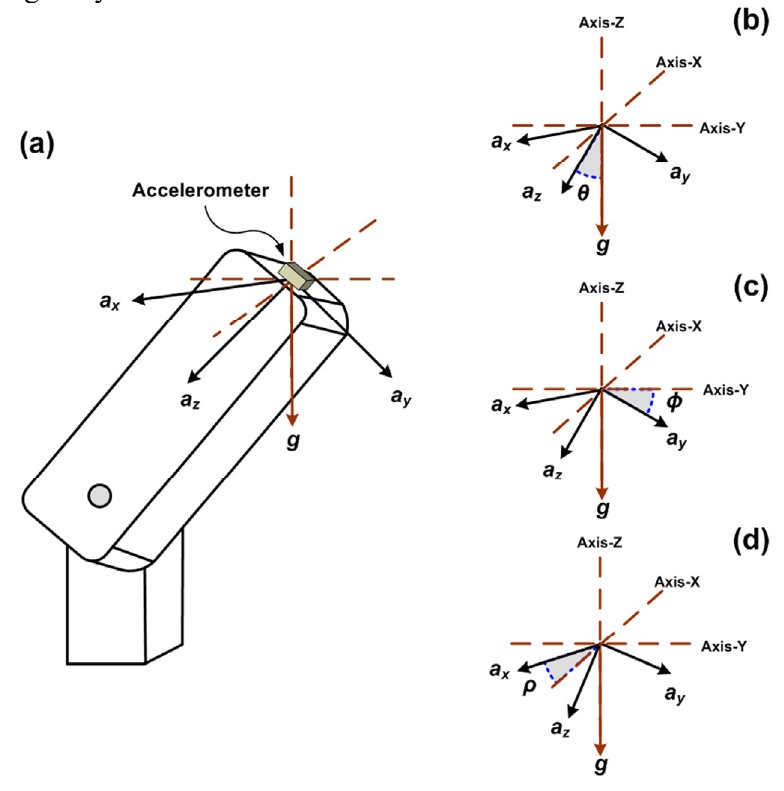
Figure 2. Triaxial accelerometer location on the robot arm, showing inclination angles with respect to